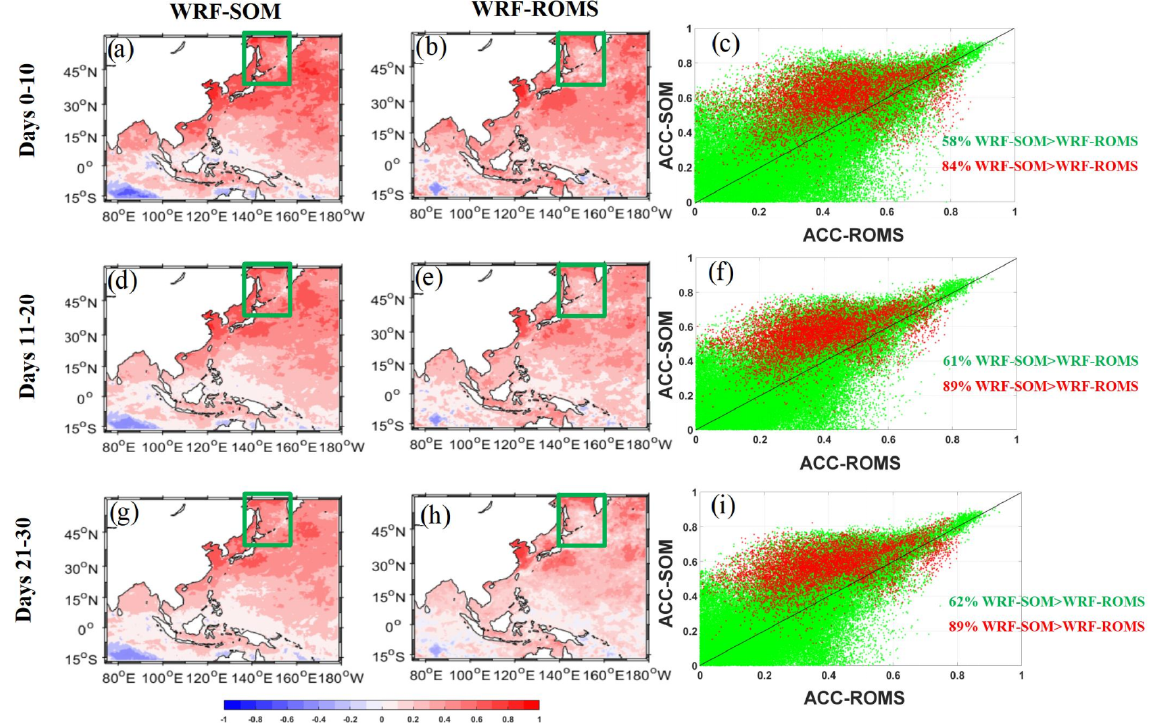
Figure 4. The spatial distributions of ACC of forecasted SSTs in the WRF-SOM (left column, panels a, d, g ), WRF-ROMS coupled models (middle column, panels b, e, h ) and their comparisons of each grid (right column, panels c, f, i ) in the model domain (green dots) including cold deviation area (red dots) against HYCOM reanalysis, averaged in the first 10d (upper panels a–c ), days 11–20 (middle panels d–f ), days 21–30 (bottom panels g–i ) forecasts of total 142 forecast cases from 19 July to 31 December